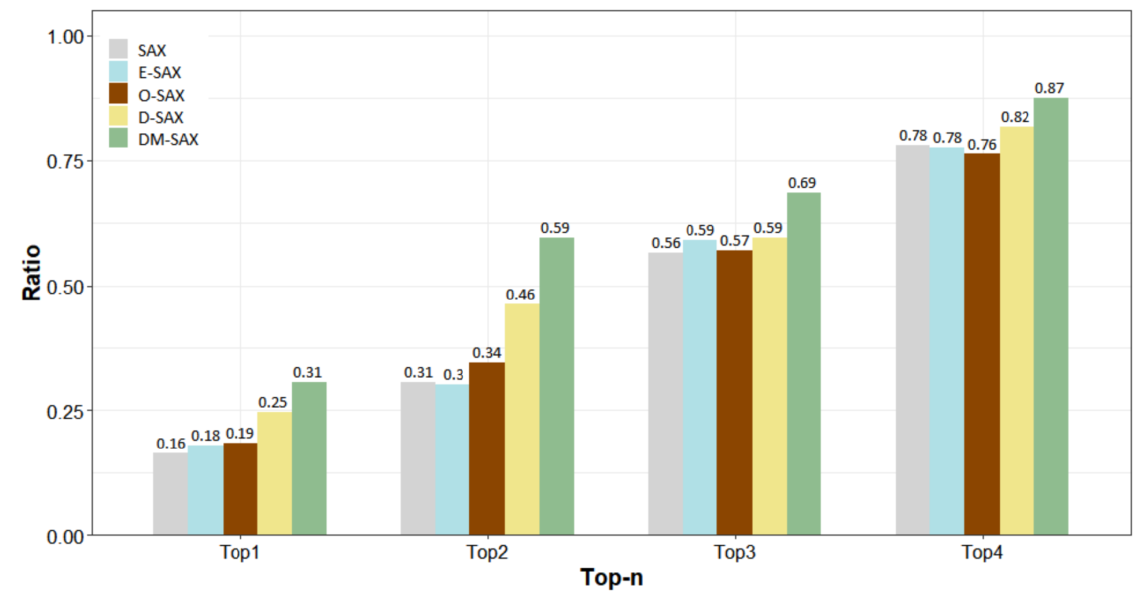
Figure 4. Ratio of each algorithm included in the top- n rank on 29 UCR datasets.